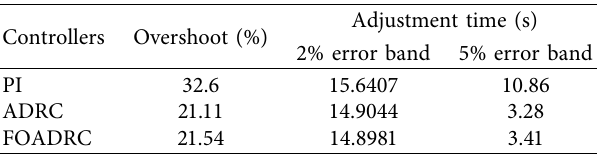
Table 3: Te dynamic performance of three controllers (double wind disturbance).